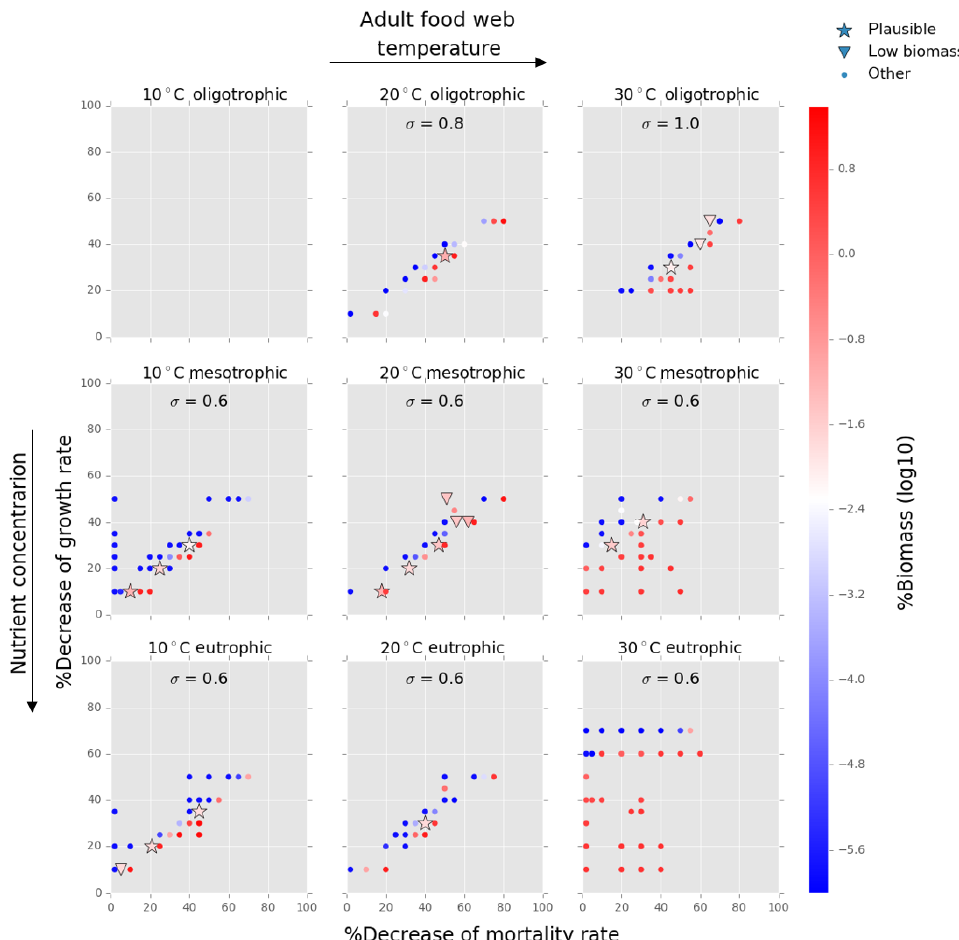
Figure 7. Results from the food web model for the calcification cost (reduction of growth) and benefit (reduction of mortality rate) for the adult life stage of planktonic foraminifera. Legend shows other for total tested simulations, low biomass for simulations for which their biomass is within the defined range and plausible for the simulations we consider to be as most likely. More details on low biomass and plausible simulations are given in Sect. 2.3, “Adding planktonic foraminifera to the model”. For all environments of 30 ◦ C, the pattern of the simulations is more scattered than for the rest environments. This is because in a range of a 0% to 50% reduction on the mortality rate, the relative biomass of planktonic foraminifera in some scenarios was high and outside the observation range. As a further reduction of the mortality rate would result in an additional increase of relative biomass, the sensitivity analysis was not